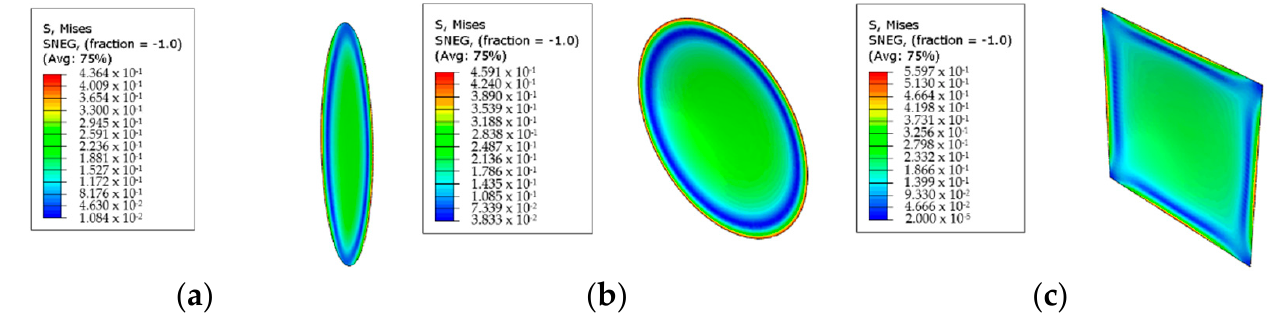
15 of 23 Pure PES Pure PVDF